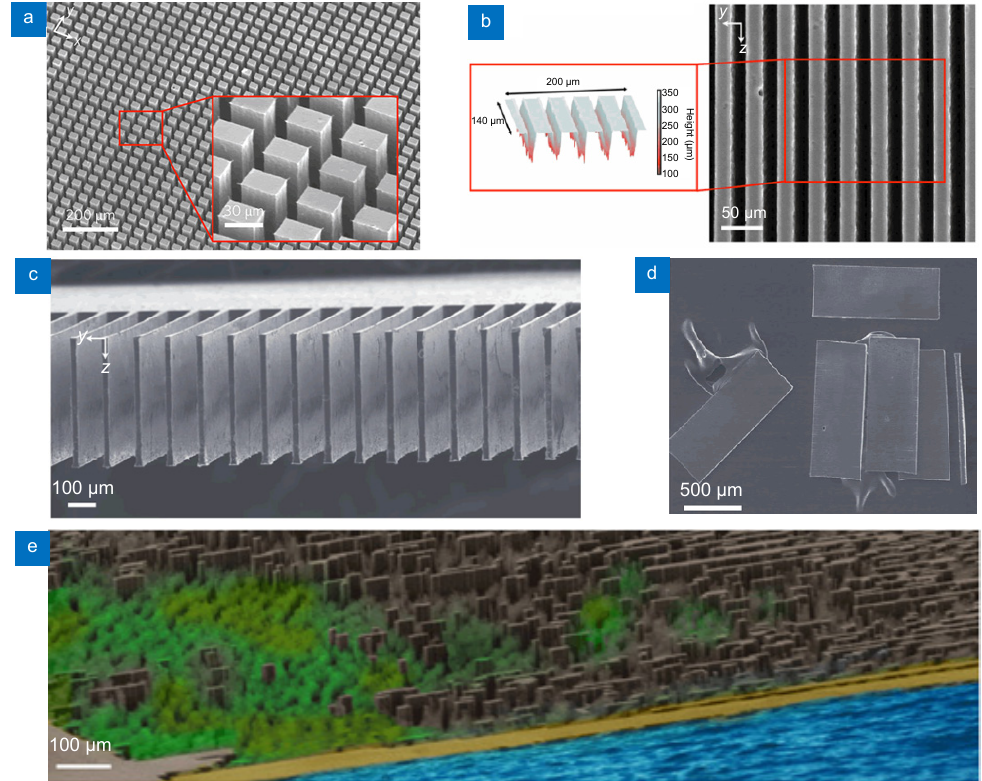
Fig. 6 | 3D arbitrary micro-architectures fabricated in silicon wafer . The SEM image of ( a ) high-aspect-ratio micropillars array and ( b ) side- wall of embedded microchannels inside silicon. Inset in (a) is the amplified view of the micropillars array. Inset in (b) is 3D profiles of the microchannels that was measured by laser scanning microscopy. ( c ) The SEM image of 3D cantilever-like structures. ( d ) SEM image of silicon plates. ( e ) An artificially coloured SEM image of a complex silicon micro-cityscape. Figure reproduced from (a–e) ref. 90 , Springer Nature.